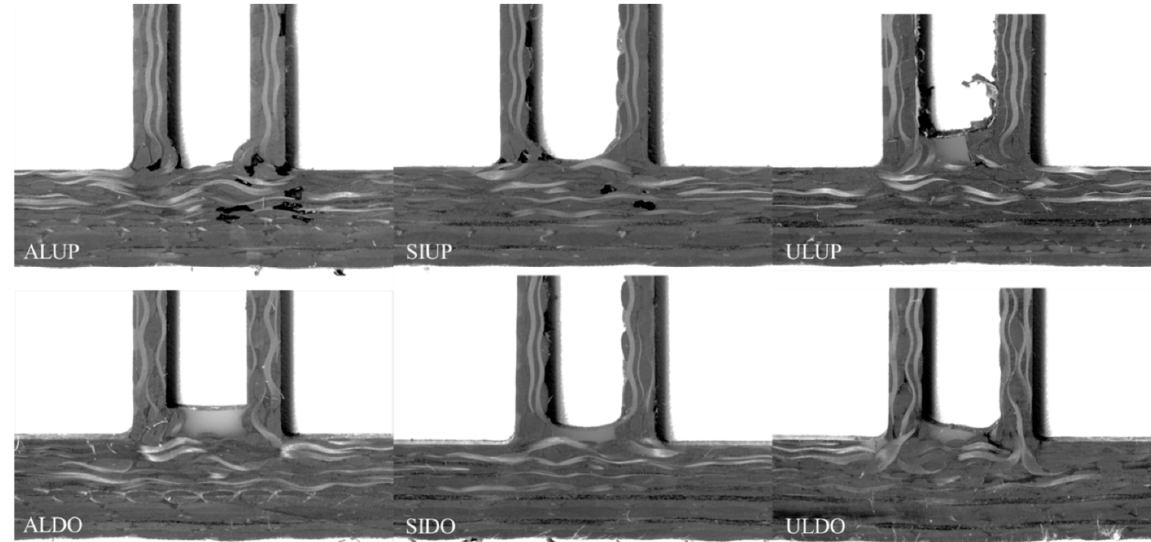
Figure 8. High-resolution scans of part cross-sections, as labelled in the bottom left corners.